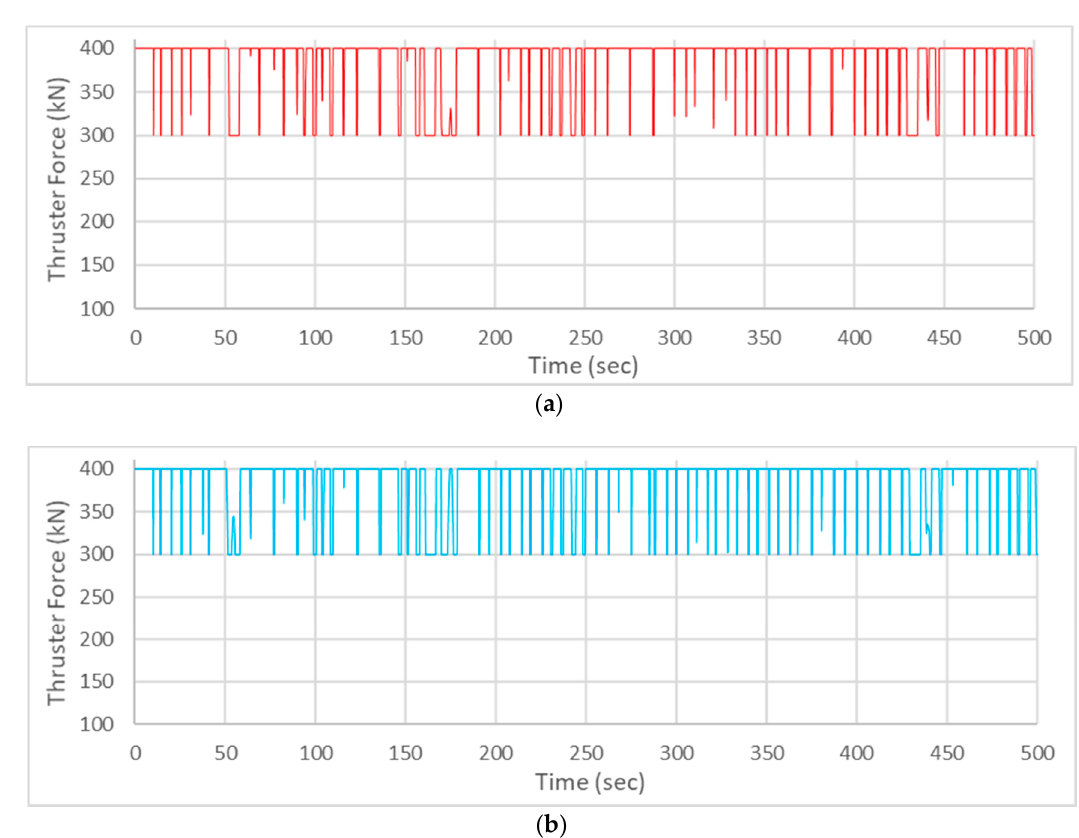
Figure 13. DP simulation with PID control showing thruster force: ( a ) Thruster 3; ( b ) Thruster 6.